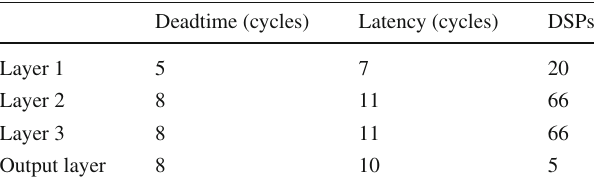
Table 1 Latency and deadtime of the individual layers of the optimised HDL